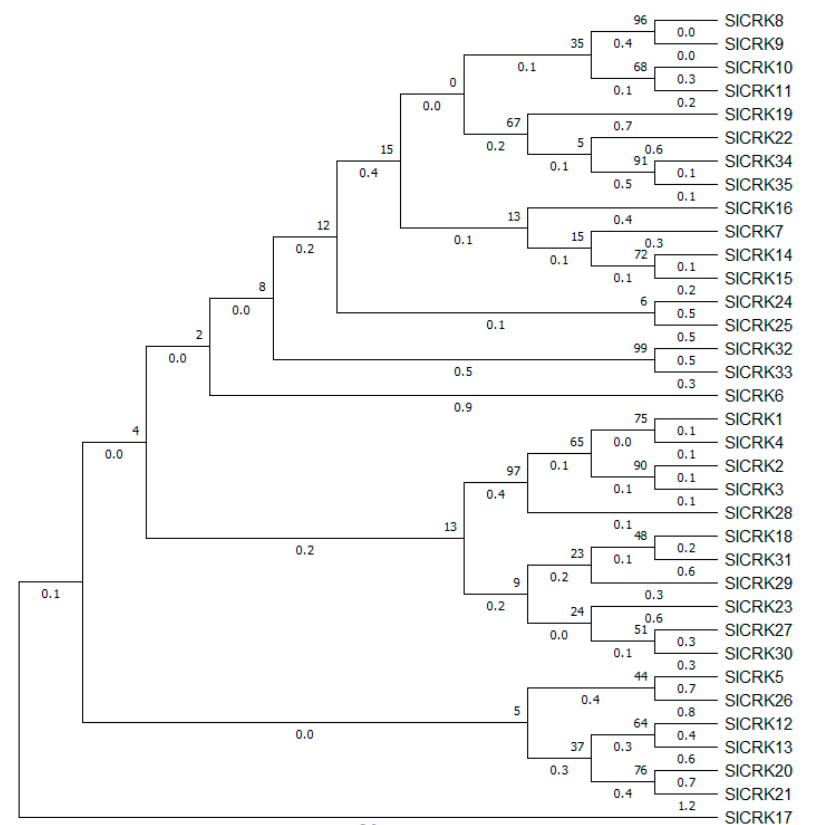
Figure 1. Phylogenic tree of SlCRK genes constructed by maximum likelihood method, JTT substi- tution model with 1000 bootstrap replicates. The numbers around the nodes indicate the branch lengths and the numbers below the branch indicates the frequency.